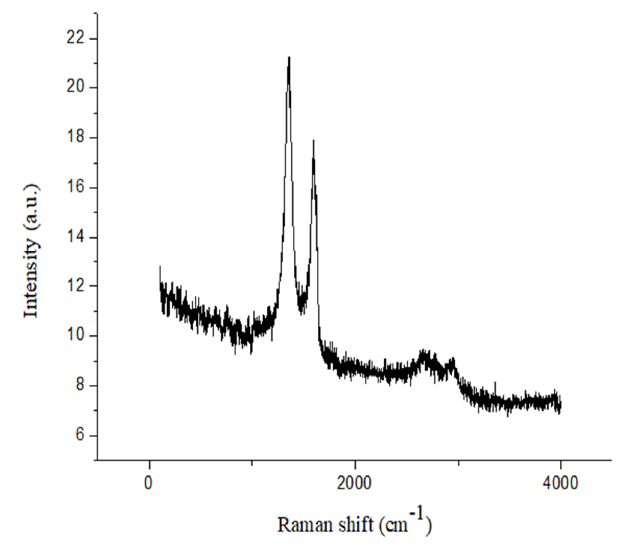
( b ) Figure 10. BJH pore size distribution curves of the ( a ) Fe/Cu nanoparticles and ( b ) rGO/Fe/Cu nanocompounds. Raman spectroscopy was used to prove the physical properties and molecular struc- ture of the rGO/Fe/Cu nanohybrids (Figure 11). The former peak and latter peak were called the D band and G band, respectively. The intensity ratio of the D band to the G band (ID/IG) is commonly referred to as a measure of the level of defects in graphene- based materials, and if ID/IG > 1, there are more structural defects [33]. In this work, the ID/IG intensity (1.18) of the rGO/Fe/Cu nanohybrids was greater than 1, indicating a large number of structural defects in the rGO/Fe/Cu nanohybrids. Figure 11 indicates that the numerous structural defects could provide more adsorption sites for dye adsorption to improve the adsorption efficiency. Figure 12 presented the magnetization properties of